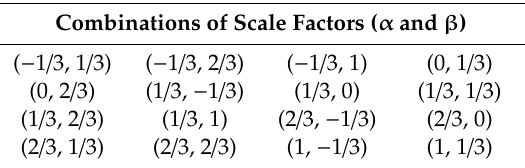
Table3. Combinationofscalefactors( α and β )toproducetheensemblemembersinthelagged-simulated perturbation (LSP) method.